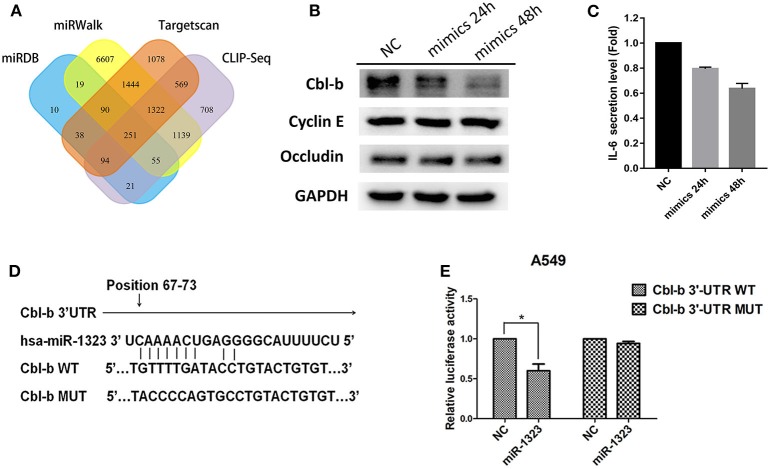
miR-1323 can promotes the migration of A549 cells through inhibiting Cbl-b. (A) A schematic view of miR-1323 predicted target genes through four miRNA databases of different mechanisms. The A549 cells were transfected with miR-1323 mimic or NC, (B) WB detected the expression of proteins and (C) Elisa detected the secretory level of IL-6 in A549 cells. (D) The bindng site of miR-1323 to Cbl-b 3′UTR. (E) The A549 cells were co-transfected with pMirTarget-Cbl-b WT (or MUT) plasmid, miR-1323 mimic (or NC), and pRL-TK. The dual luciferase reporter assay detected the activity of luciferase. The histogram shows the relative activity of luciferase. t-test was used to assess statistically signifificant differences between groups.Mean ± SD, results of three independent experiments, *p < 0.05.